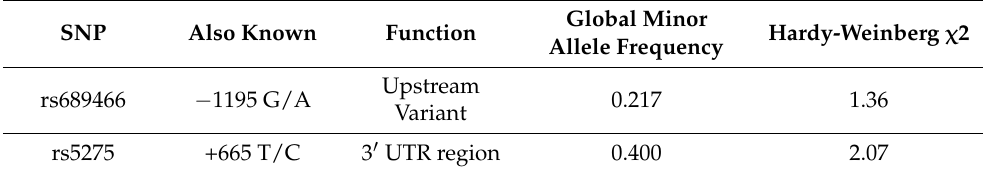
Global Minor Hardy-Weinberg χ 2 Allele Frequency Upstream 0.217 1.36 Variant